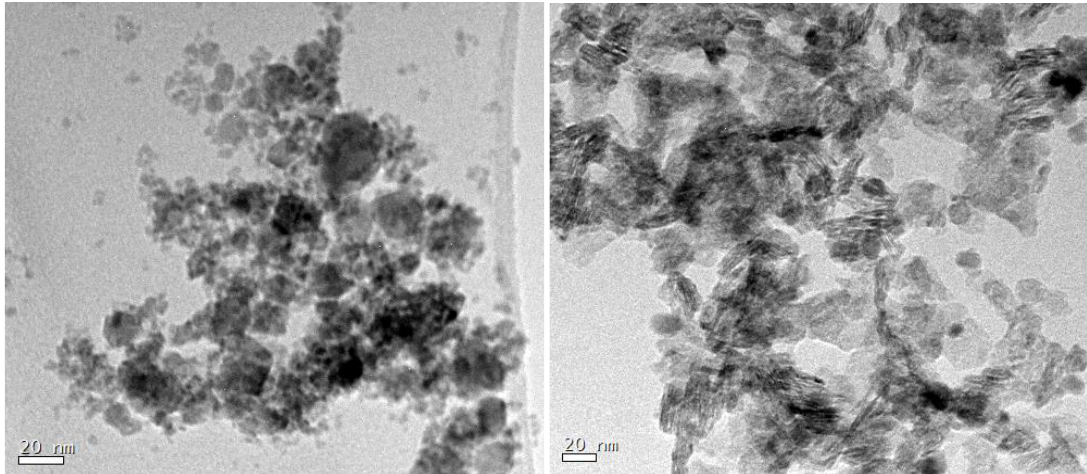
Figure 2. Transmission electron microscopy (TEM) micrograph of ( left ) as-prepared NiFe 2 O 4 NPs and ( right ) NiFe 2 O 4 -LDH composite.